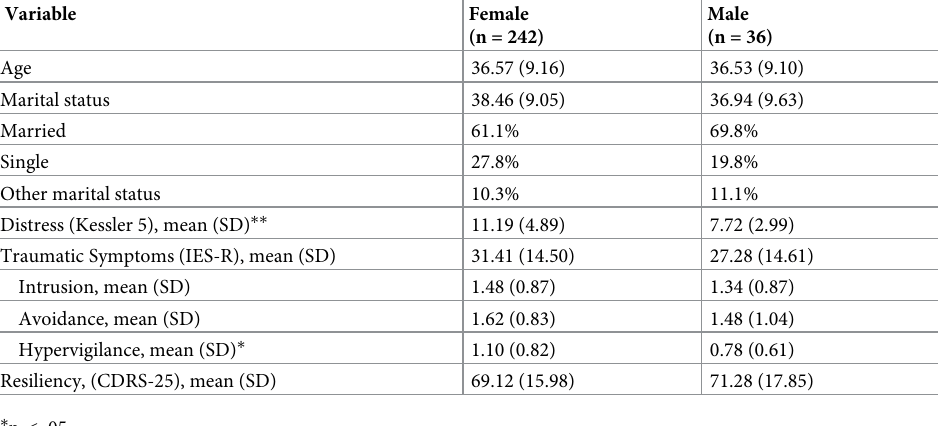
Table 5. Demographic and mental health scale differences within qatari by sex (n = 278). Demographic and mental health scale differences within Qatari citizens by sex with sample size 278 (242 female, 36 male).